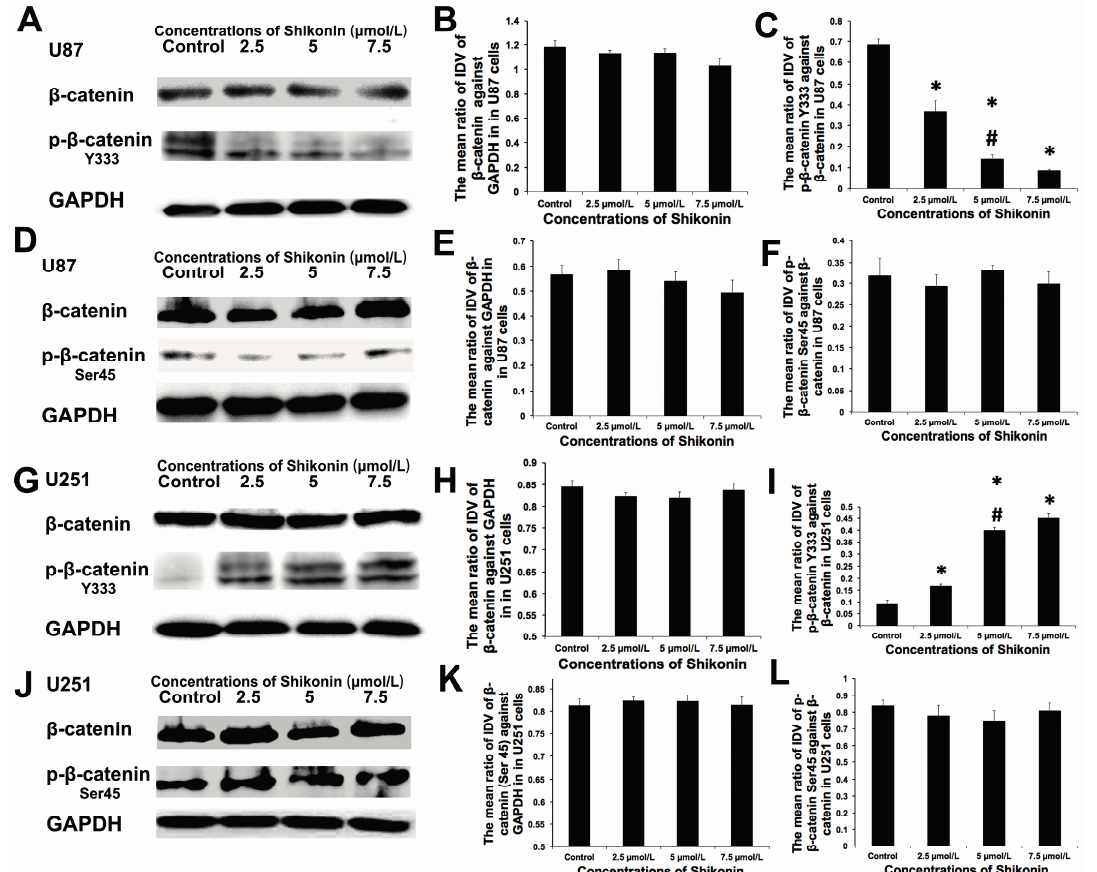
Figure 5. The regulation of p- β -catenin expression by shikonin. The expression of p- β -catenin was significantly inhibited by the treatment of shikonin in a dose-dependent manner at Y333 whereas it was not altered at Ser45 in U87 cells. However, there was no significant difference between the concentrations of 5 and 7.5 μ mol/L at Y333. U251 cells were treated similarly to U87 cells. The expression of p- β -catenin Y333 was significantly upregulated due to treatment with shikonin. Again, there was no significant difference between the concentrations of 5 and 7.5 μ mol/L. ( A ) Western blot assay results of β -catenin and p- β -catenin Y333 in U87 cells; ( B ) Statistical analysis of β -catenin expression levels in U87 cells; ( C ) Statistical analysis of p- β -catenin Y333 expression levels in U87 cells; ( D ) Western blot assay results of β -catenin and p- β -catenin Ser45 in U87 cells; ( E ) Statistical analysis of β -catenin expression levels in U87 cells; ( F ) Statistical analysis of p- β -catenin Ser45 expression levels in U87 cells; ( G ) Western blot assay results of β -catenin and p- β -catenin Y333 in U251 cells; ( H ) Statistical analysis of β -catenin expression levels in U251 cells; ( I ) Statistical analysis of p- β -catenin Y333 expression levels in U251 cells; ( J ) Western blot assay results of β -catenin and p- β -catenin Ser45 in U251 cells; ( K ) Statistical analysis of β -catenin expression levels in U251 cells; ( L ) Statistical analysis of p- β -catenin Ser45 expression levels in U251 cells. * p < 0.01 compared with control group; # p < 0.01 compared with the former ( n =